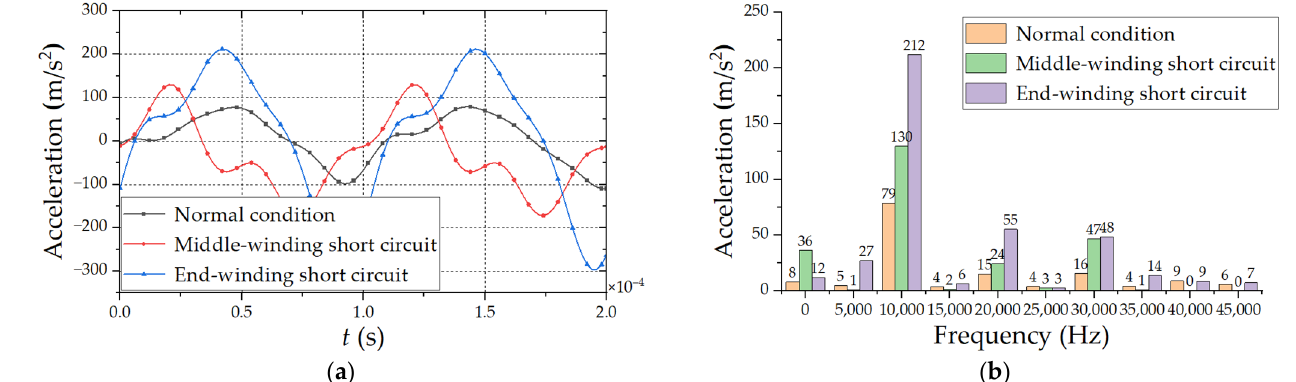
Figure 10. Comparison of vibration acceleration under different interleaved winding fault positions ( a ) Time domain waveform diagram; ( b ) Harmonic response analysis.